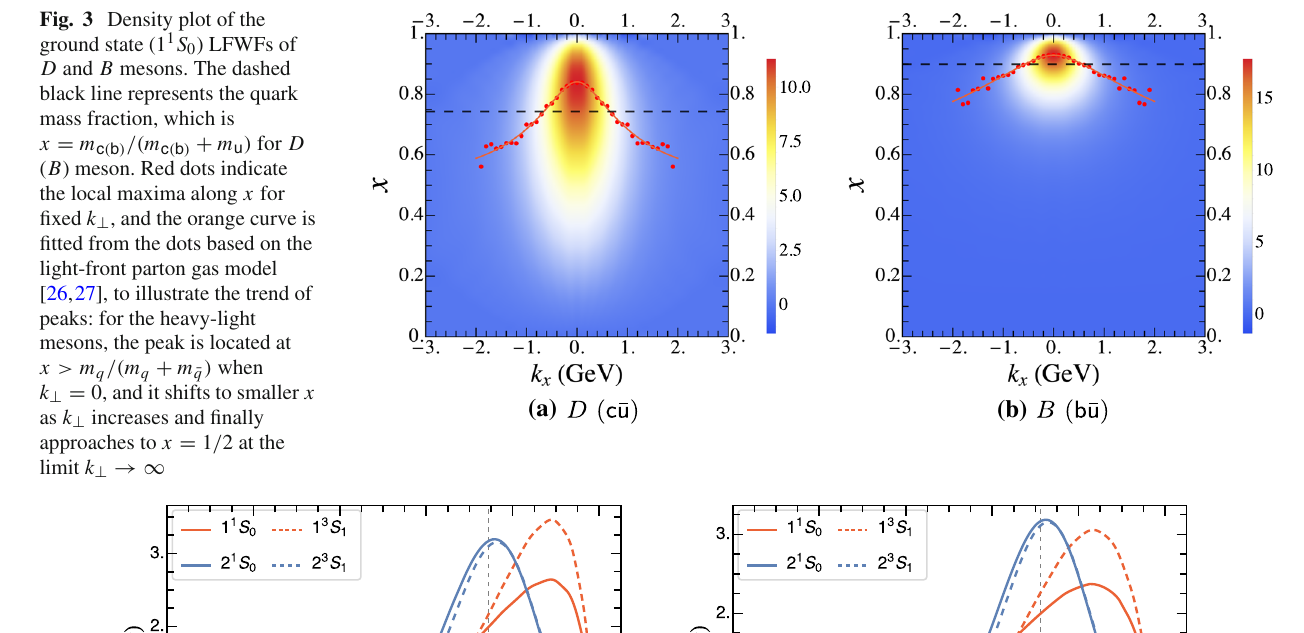
Fig. 3 Density plot of the ground state (1 1 S 0 ) LFWFs of D and B mesons. The dashed black line represents the quark mass fraction, which is x = m c ( b ) /( m c ( b ) + m u ) for D ( B ) meson. Red dots indicate the local maxima along x for fixed k ⊥ , and the orange curve is fitted from the dots based on the light-front parton gas model [26,27], to illustrate the trend of peaks: for the heavy-light mesons, the peak is located at x > m q /( m q + m ¯ q ) when k ⊥ = 0, and it shifts to smaller x as k ⊥ increases and finally approaches to x = 1 / 2 at the